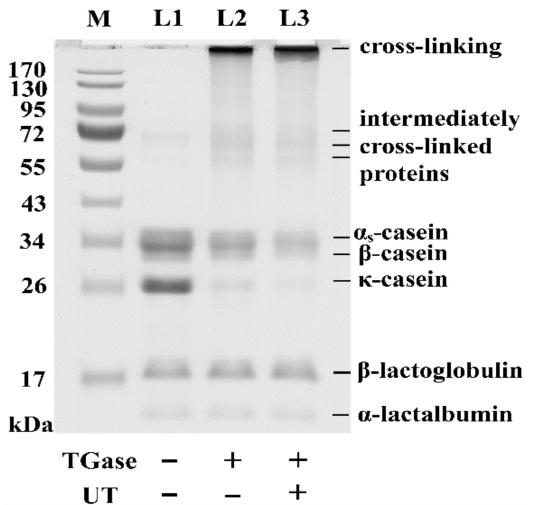
Figure 1. SDS-PAGE image showing skim milk incubated with/without TGase (6.0 units/mL) and with/without UT at 30 ◦ C for 60 min. (L1) Milk, (L2) milk with TG, and (L3) milk with TGase and UT. M = protein marker. The experiments on the sample were performed in